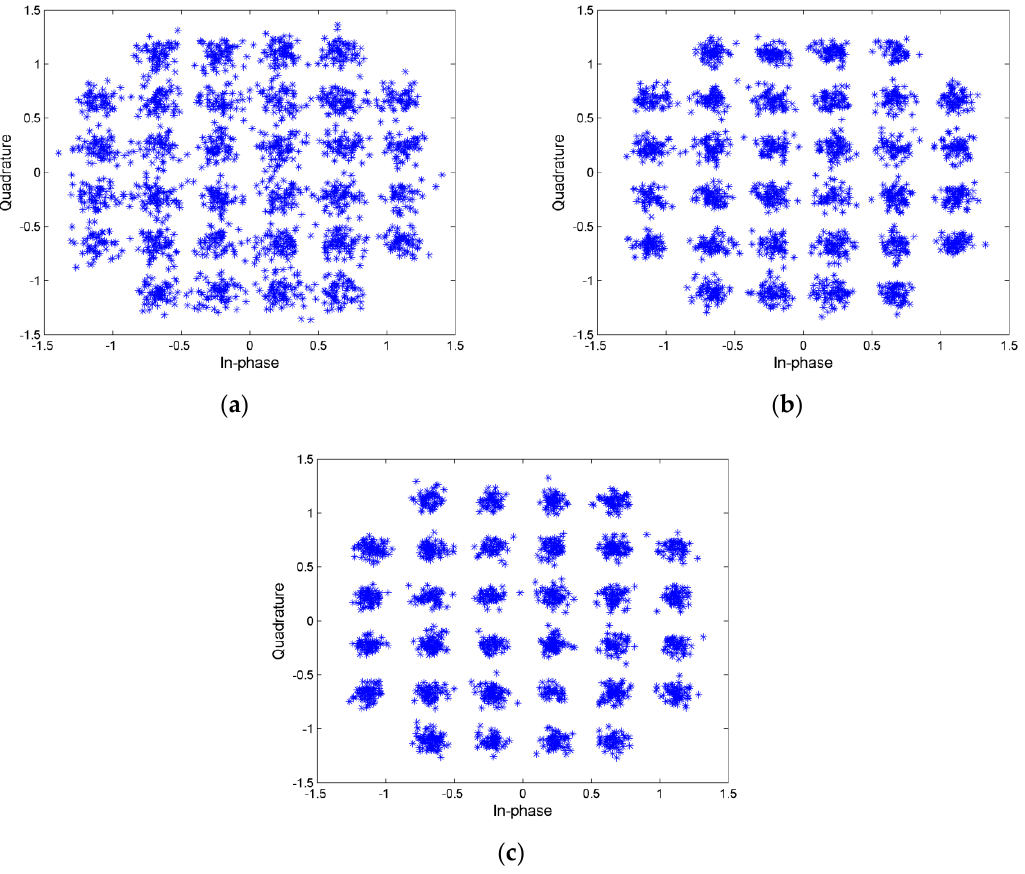
Figure 12. Received constellations of DMT signals operated at 22 mA point ( a ) without pre ‐ distorter ( b ) with the conventional approach ( c ) with the proposed pre ‐ distorter. ( b ) with the conventional approach ( c ) with the proposed pre-distorter.